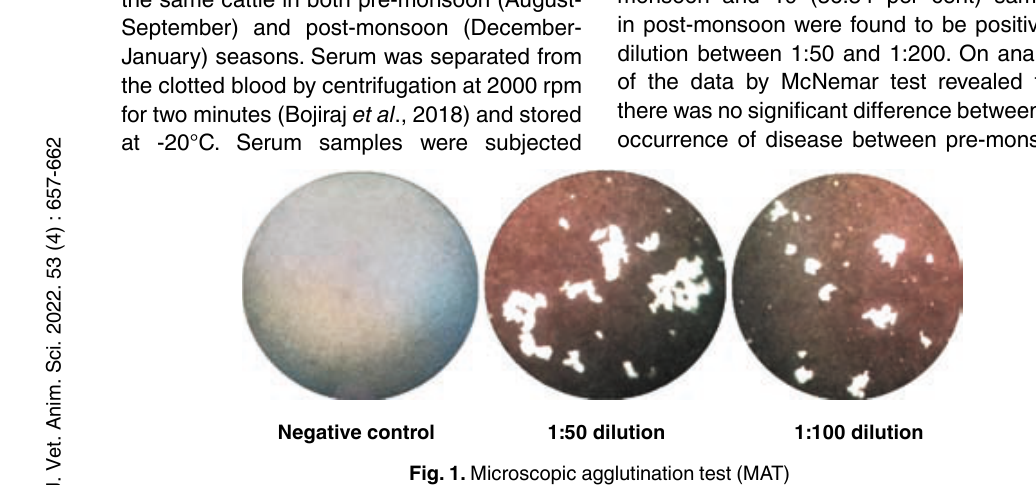
Fig. 1. Microscopic agglutination test (MAT) J .